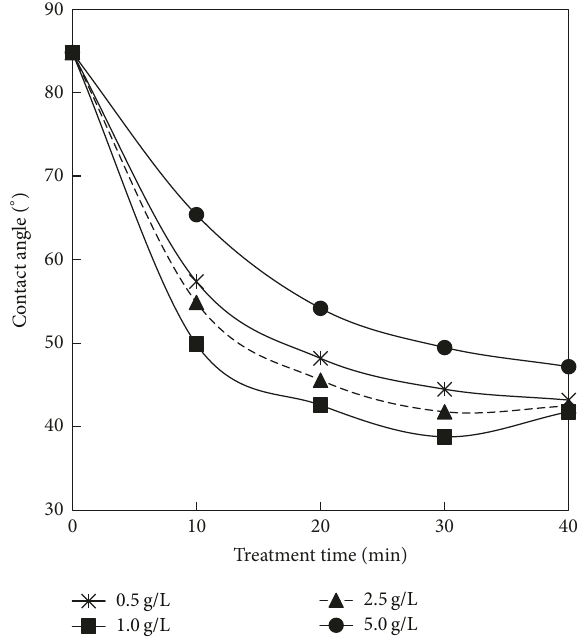
Figure 1: Dependence of the surface contact angle upon the TiO 2 content and the treatment time under 300 W UV